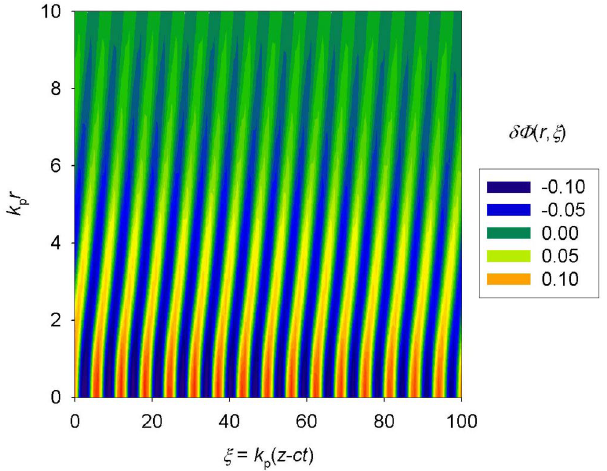
FIG. 3. (Color) Model prediction for wakefield potential distri- bution (cid:7) (cid:1) (cid:5) r; (cid:5) (cid:6) plotted after a propagation distance of 2.62 mm (cid:1) 2 : 97 ps for t d